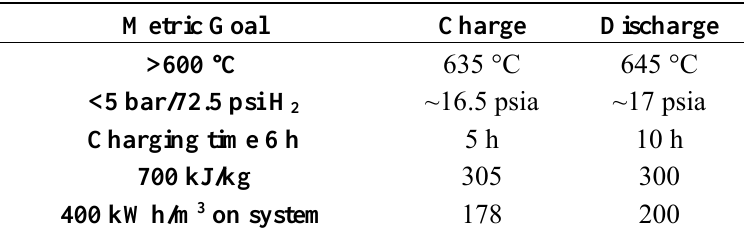
Figure 21. ( a ) Hydrogen flow rate during discharging and ( b ) charging towards time for cycle #5. Table 2. Summary of measured parameters compared to metrics. Note that the assumed density changed from 3.068 g/mL to 1.384 g/mL achieved, which impacts the volumetric storage by a factor of